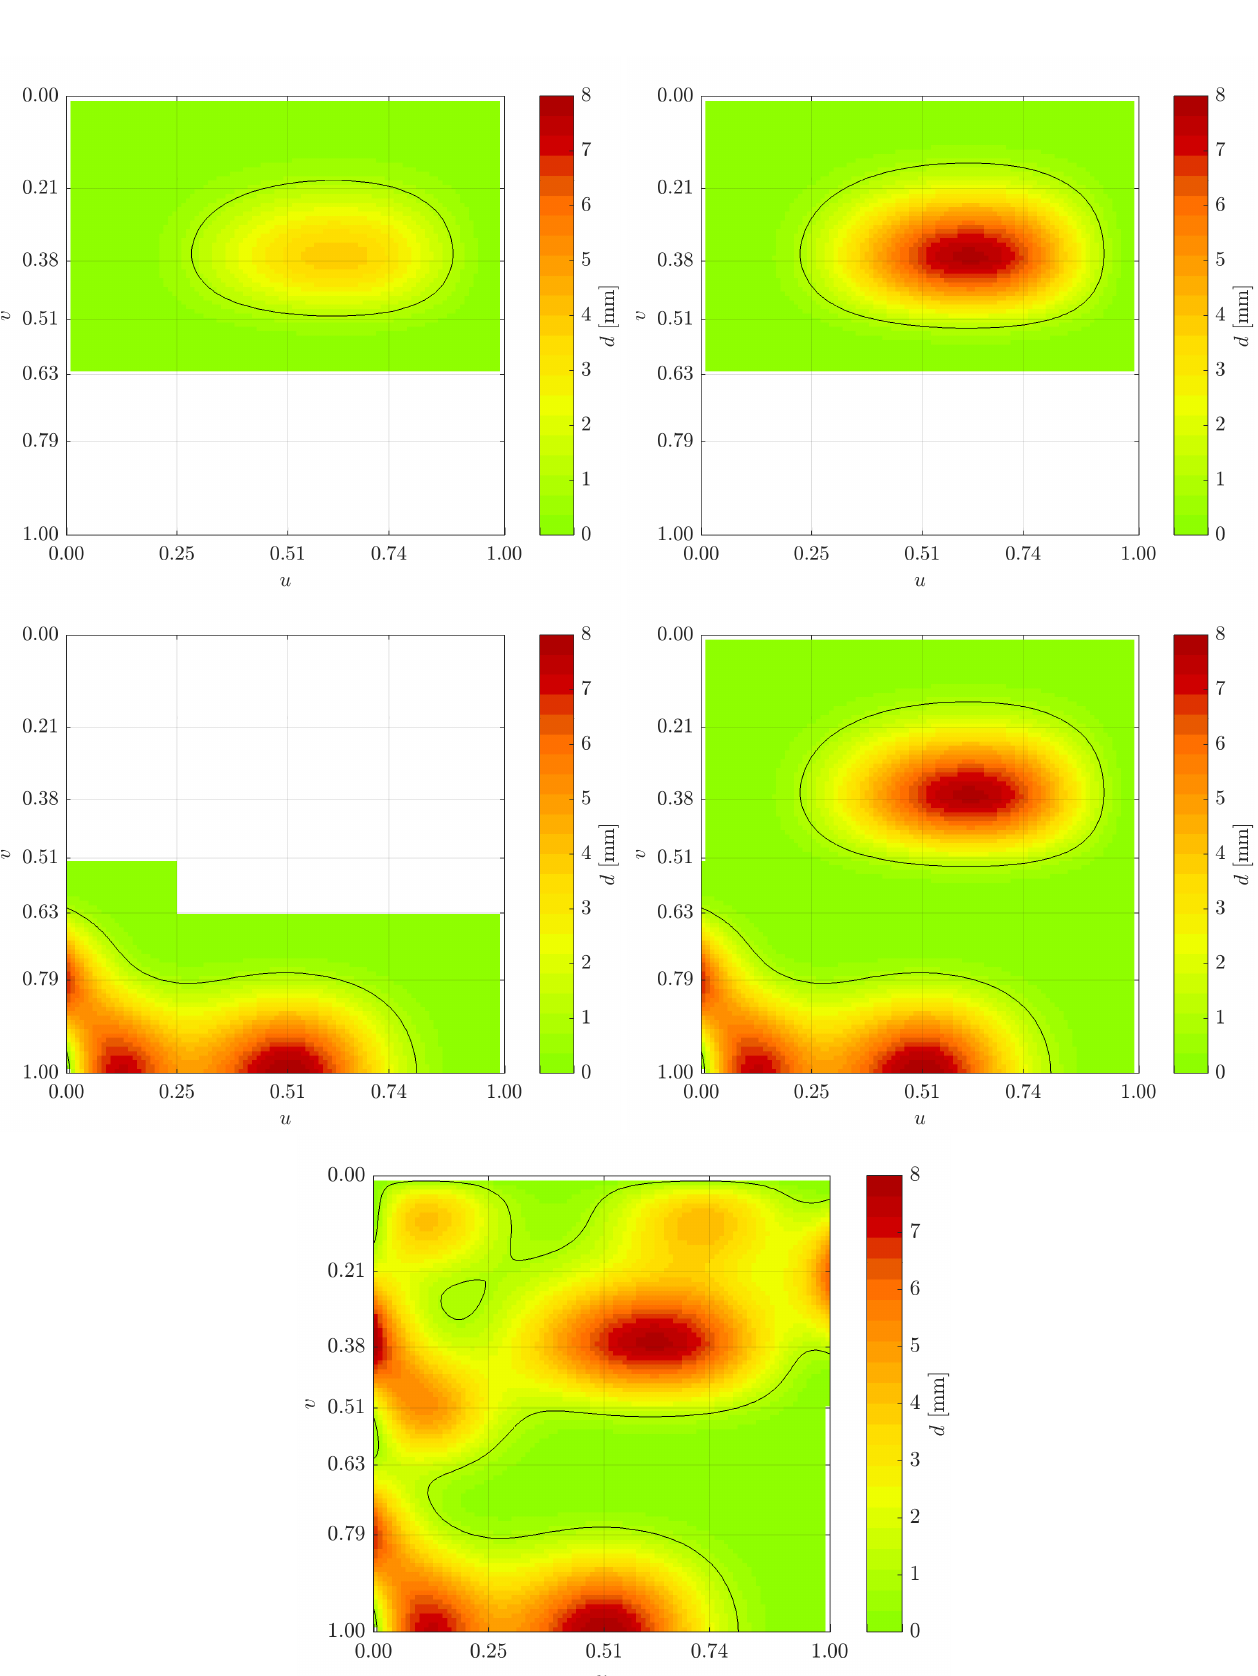
Figure 9. Simulated distortions, presented in the parameter space. The knot grid is indicated by the grey lines. Top left: V15; top right: V20; middle left: V18; middle right: V40; bottom: V65